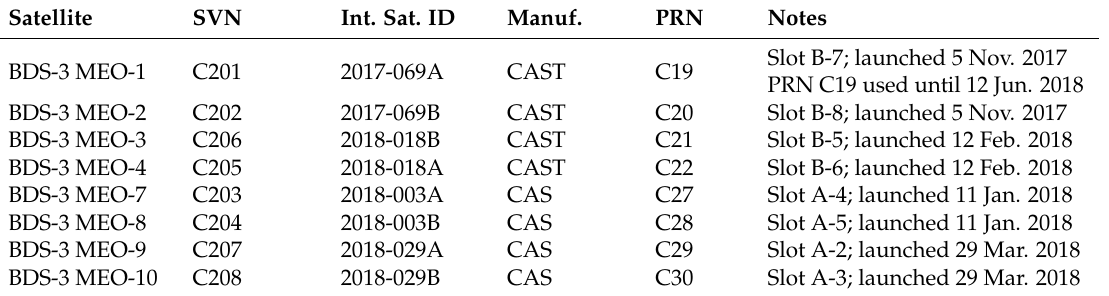
Table 1. Status of the BDS-3 satellites (June 2018).